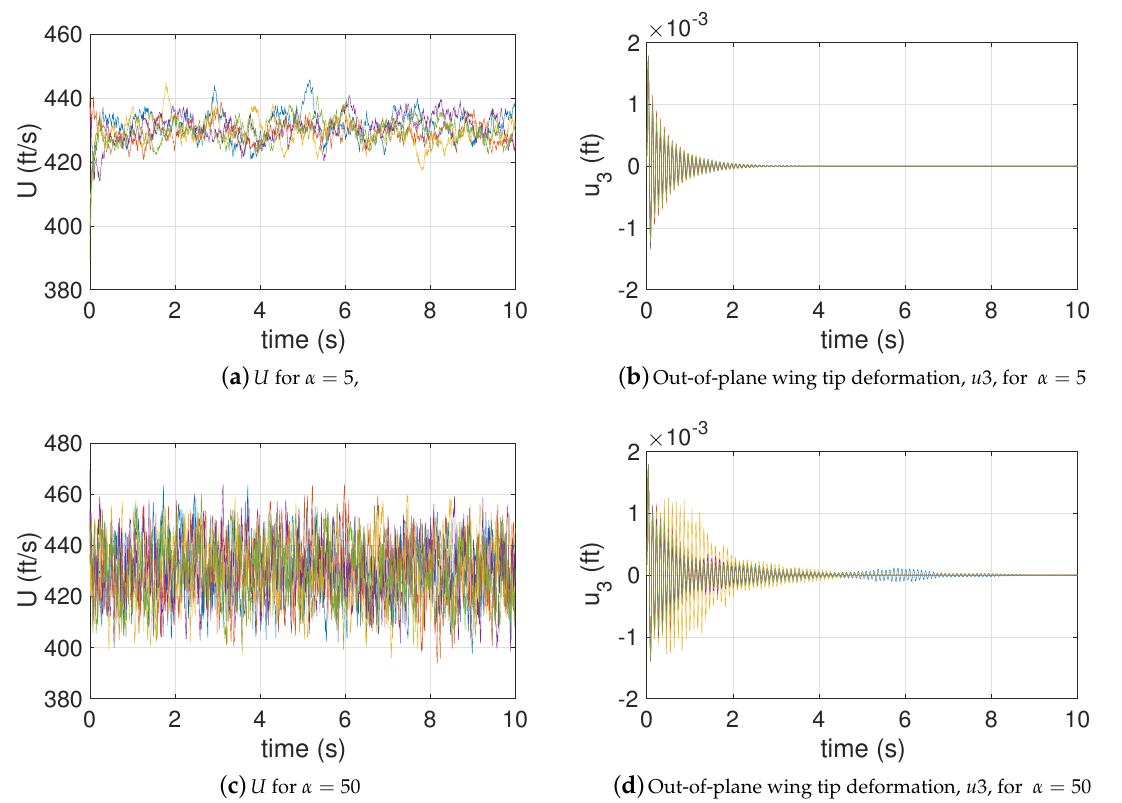
( d ) Out-of-plane wing tip deformation, u 3, for α = 50 Figure 18. Goland Wing Oscillation with correlation function, r xx = e − ατ , where U ave = 430 ft/s, and ∆ =